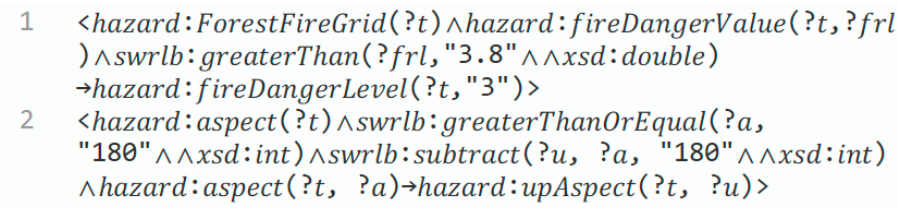
Figure 12. Production reasoning process.